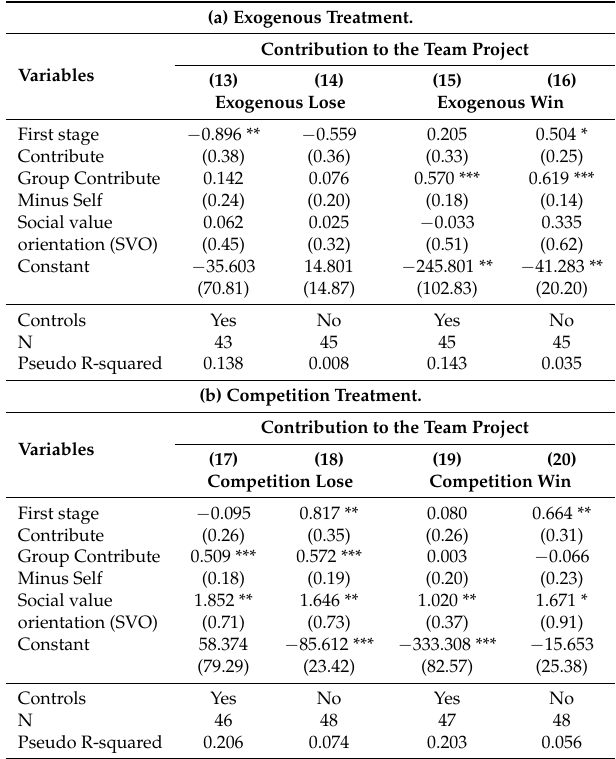
Table A3. Tobit models with limits at 0 and 100. (a) Exogenous Treatment.